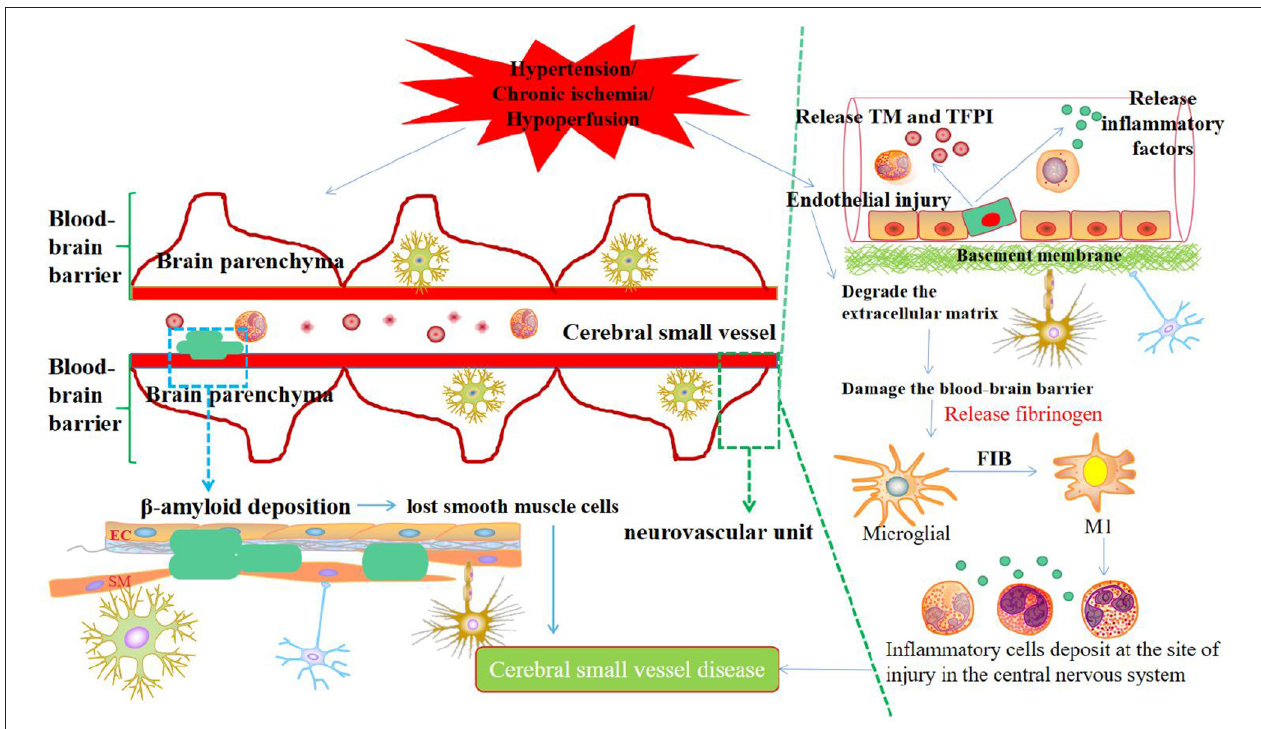
FIGURE 1 | Synthetic diagram of the mechanism of